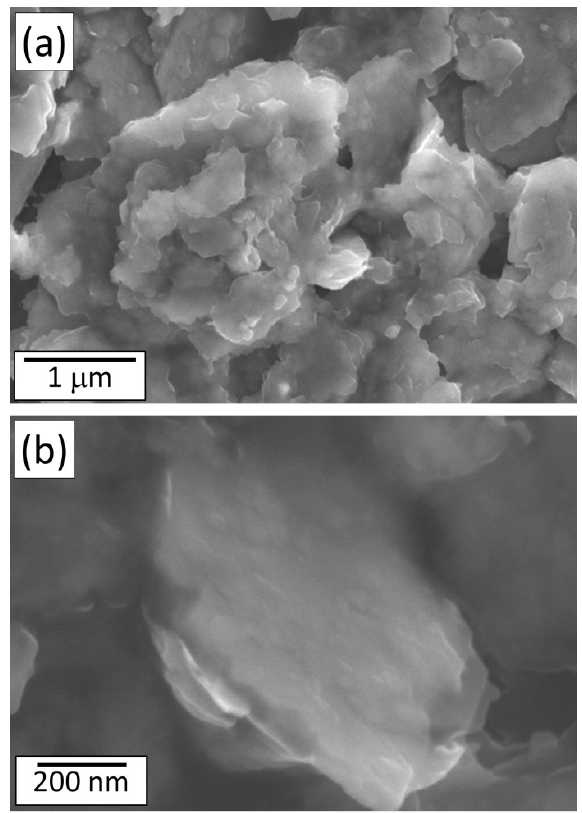
Figure 1. SEM images of the sub-2 µ m total clay fraction of the contaminant solids ( a , b ).